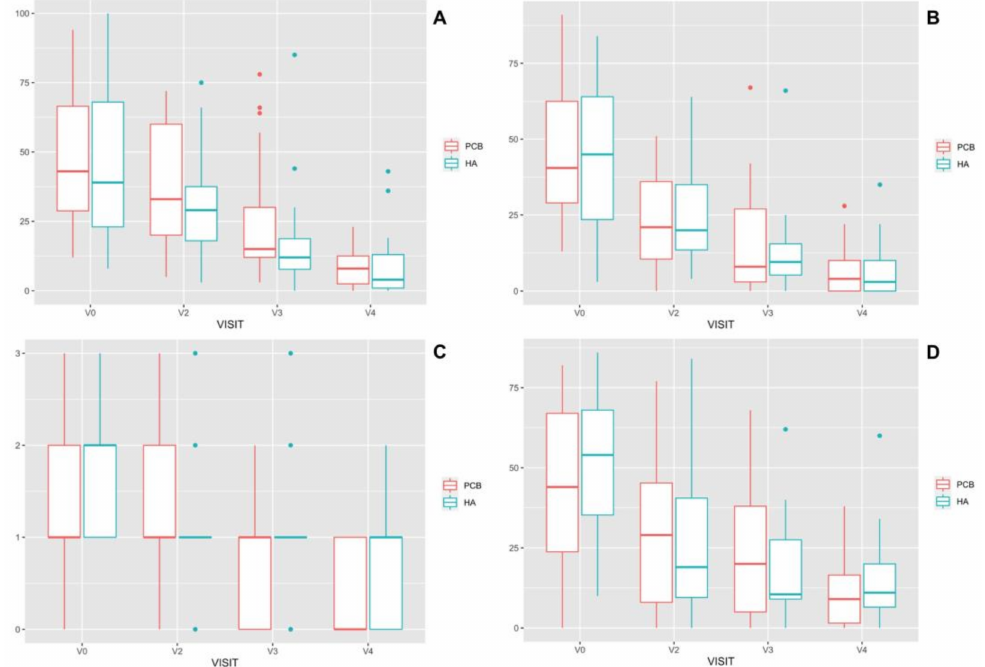
Figure 2. Box and whisker plots for lameness (VAS) ( A ), pain (VAS) ( B ), lameness semi-quantitative scale ( C ) evaluation by veterinarian, and pain (VAS) ( D ) evaluation by the owner; by protocol and visit. Median, range and